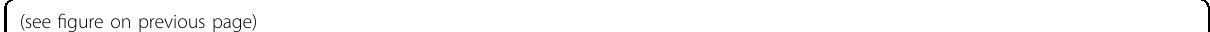
Fig. 4 TICs, TME scores, and PI3K-Akt signaling pathway were associated with the survival and clinicopathological characteristics of TNBC patients. A The top 20 DEGs in fi ve different types of breast cancer and normal breast tissue samples (GSE65194), **** P -value < 0.0001. [TNBC ( n = 55), Her2 ( n = 39), Luminal B ( n = 30), Luminal A ( n = 29), Healthy ( n = 11)]. B The barplot showing the different proportions of 22 TICs in different types of breast cancer samples ( n = 103). C The correlations between 22 different kinds of TICs. The value in each small box represents the P value of correlation between the two kinds of TICs. The chroma of each small color box represents the corresponding correlation value between the two kinds of TICs. Pearson coef fi cient is used for the signi fi cance test. D The violin plot showed the signi fi cantly differentially expression of immune cells between TNBC ( n = 55) and non-TNBC ( n = 48) samples. E , F Kaplan – Meier survival analysis depending on overall survival (OS) ( E ) or metastases-free survival (MFS) ( F ) was performed for breast cancer patients with high or low ESTIMATEScore, StromalScore, and ImmuneScore, respectively. G – I Distribution of ESTIMATEScore, StromalScore, and ImmuneScore in histological type ( G ), PR ( H ), Her2 ( I ). J , K The heatmap ( J ) and volcano ( K ) for 3378 DEGs. The patients were grouped according to their high and low ImmuneScore. L , M The heatmap ( L ) and volcano ( M ) for 3378 DEGs. The patients were grouped according to their high and low StromalScore. The DEGs were calculated by Wilcoxon rank sum test. The results with the criterion of logFC > 0.8, P < 0.01, and false discovery rate (FDR) < 0.01 as the signi fi cance threshold. N – O The venn diagram showed 1153 upregulated DEGs ( N ) and 2591 downregulated DEGs ( O ) both in data regarding ImmuneScore or StromalScore. P – Q GO and KEGG enrichment analysis for 3744 DEGs displayed the enrichment of immune-related GO terms ( P ) and signaling pathways ( Q ), with p and q value < 0.05 as the signi fi cance threshold. R The heatmap showed that the 77 genes enriched in the PI3K-Akt signaling pathway have different expression levels in different subtypes of BCa, **** p < 0.0001. S The Venn diagram showed the 23 target genes through the cross-analysis of genes from PI3K-Akt signaling pathway and target genes of miR-637. T , U The expression levels of Akt1 ( T ) and CCND1 (cyclinD1) ( U ) between different types of breast